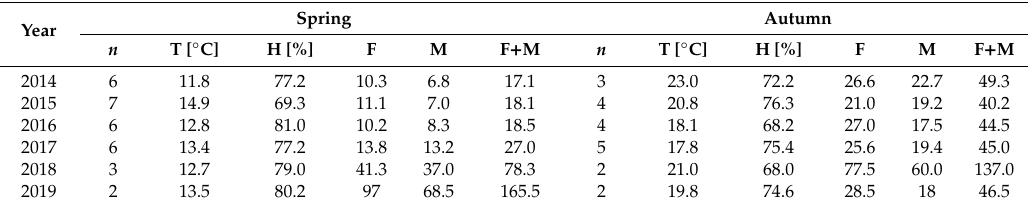
Table 1. Mean values of D. reticulatus ticks collected in Polesie National Park per 100 m 2 .